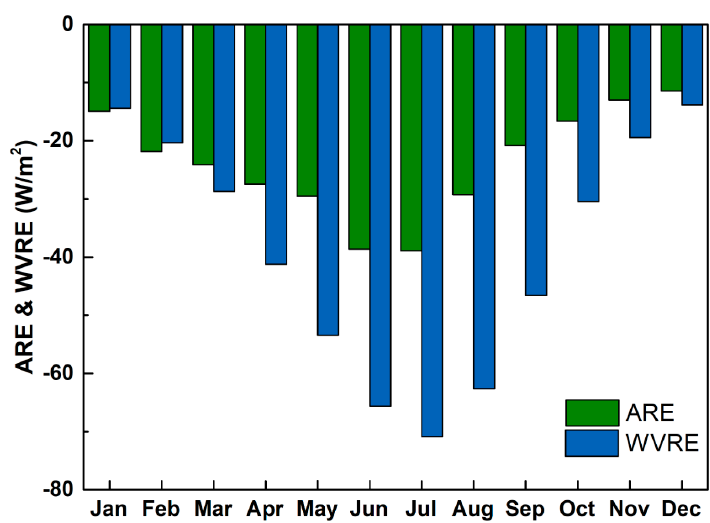
Figure 9. Monthly variations of ARE and WVRE in northern China during 2001–2015.